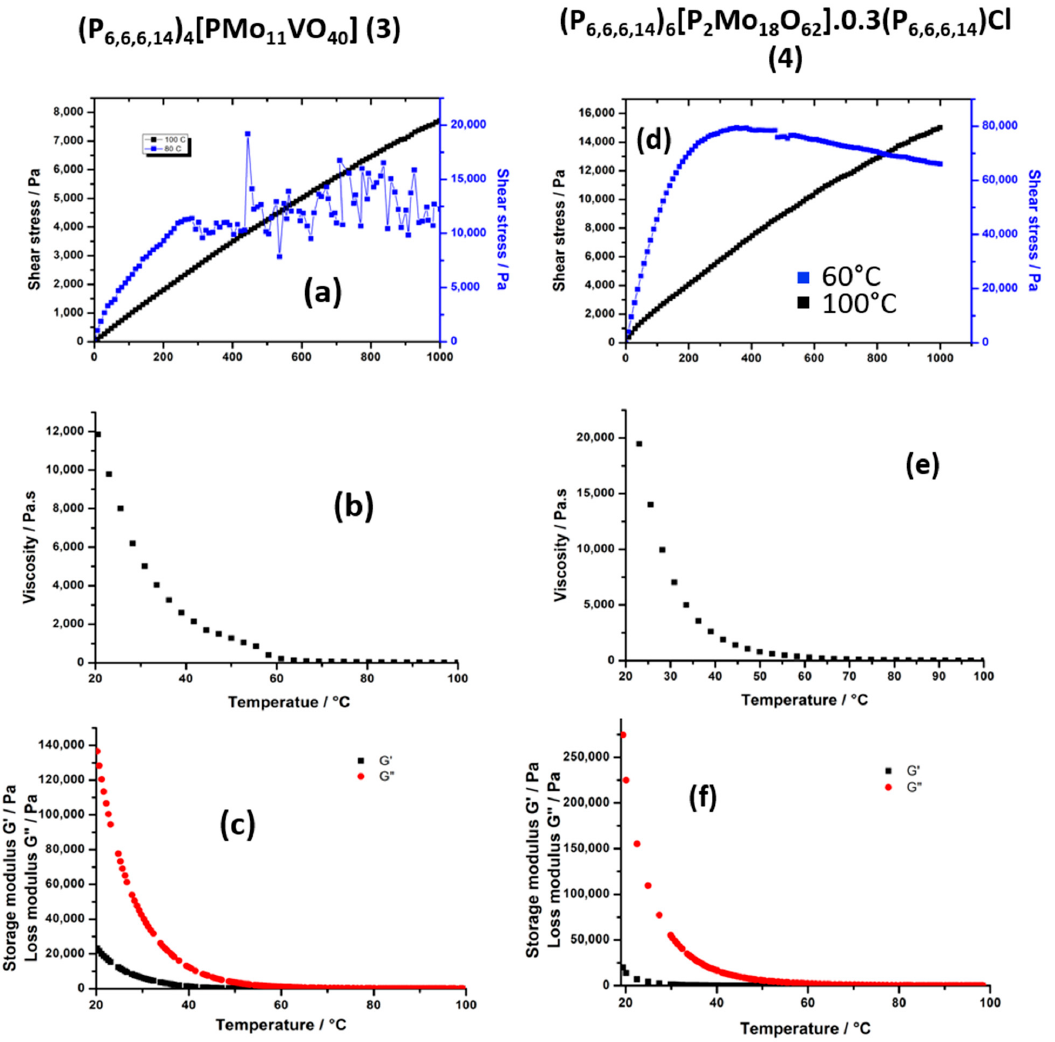
. Figure 6. Flow curves τ = f( γ ) measured at 80 and 100 ◦ C for 3 ( a ) an 60 and 100 ◦ C for 4 ( d ); Viscosity variation as a function Figure 6. Flow curves τ = f( 𝛾(cid:4662) ) measured at 80 and 100 °C for 3 ( a ) an 60 and 100 °C for 4 ( d ); Viscosity variation as a function . of the temperature between 20 °C and 100 °C (cid:4666)𝛾 (cid:4662) = 10 s − 1 ) for 3 ( b ) and 4 ( e ); Temperature dependence of G’ (black dots) γ = 10 s − 1 ) for 3 ( b ) and 4 ( e ); Temperature dependence of G (cid:48) (black dots) of the temperature between 20 ◦ C and 100 ◦ C ( and G’’ (red dots) with 20% strain and f = 1 Hz for 3 ( c ) and 4 ( f ). and G” (red dots) with 20% strain and f = 1 Hz for 3 ( c ) and 4 ( f